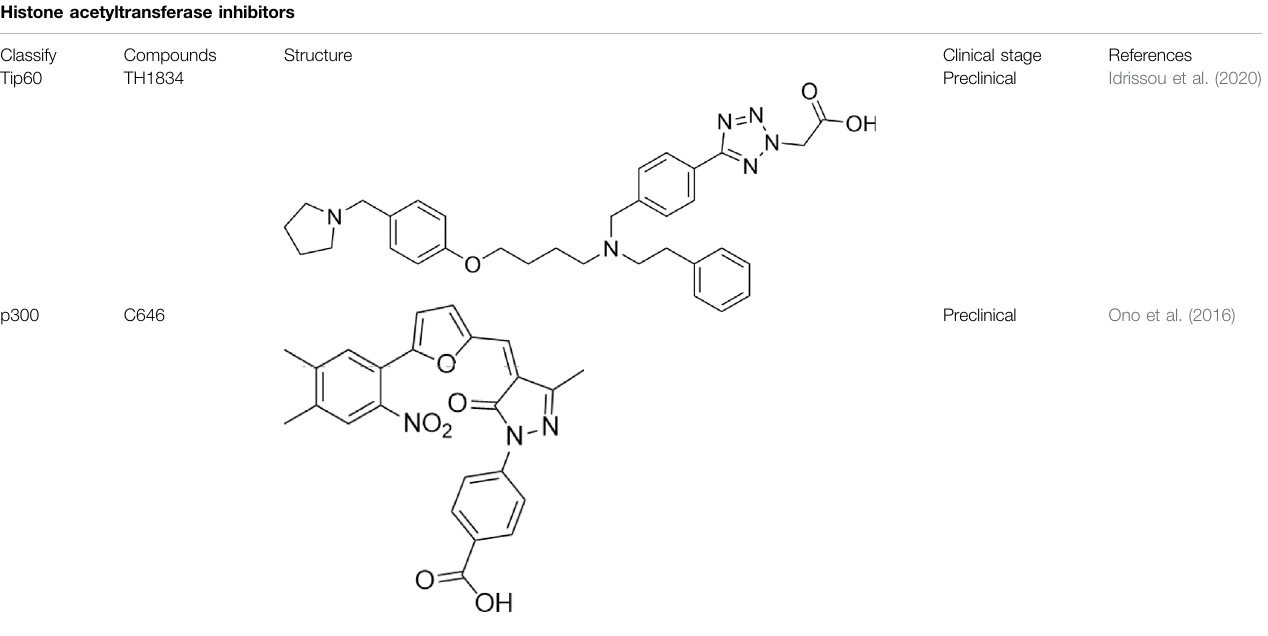
TABLE 6 | A list of histone acetyltransferase inhibitors under different phases of clinical trial and their indication. Histone acetyltransferase inhibitors